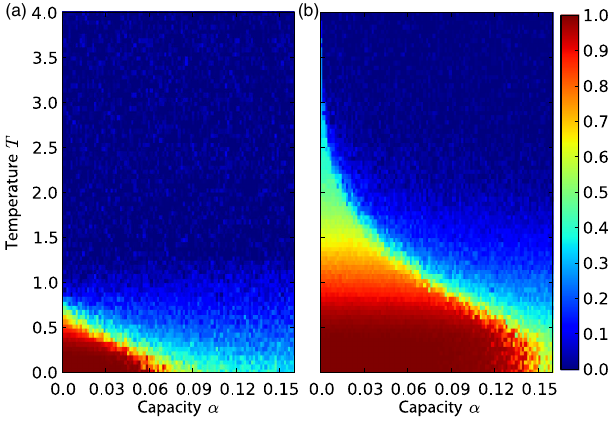
FIG. 14. Quality of retrieval in dependence of capacity α and temperature T . Numerical results for the overlap m , averaged over 20 realizations. Parameters are the same as in Fig. 5 with D ¼ 0 . 8 . The network model with nonadditive dendrites displays (b) a larger region of stable memory retrieval than (a) the original Hopfield